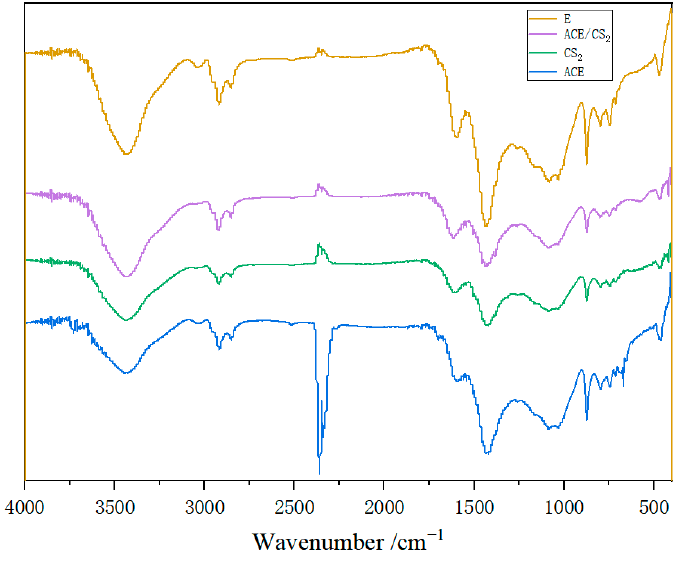
Figure 6. Infrared spectra of coal tar residue and its three extractive residues.